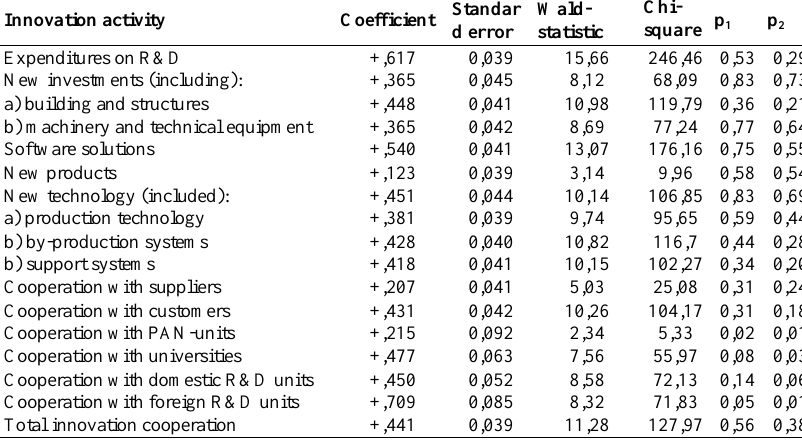
Table 4. Coefficient value by independent variable „foreign range”, in probit models describing innovation activity in the polish manufacturing